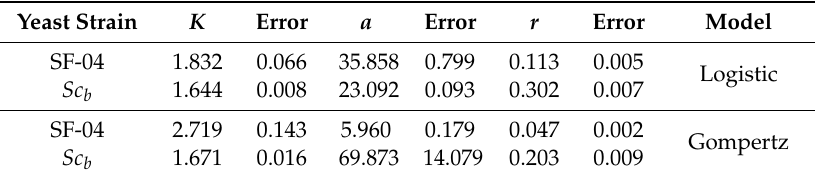
Table 3. Parameter estimates of k , a , r and their errors for the logistic and Gompertz models applied to the absorbance measurements at 630 nm for the Saccharomyces cerevisiae (SF-04) and Saccharomyces cerevisiae var. boulardii ( S Cb ) strains cultured in batch bioreactors at 24 ± 1 ◦ C for 50 h. All these results are statistically significant ( p < 0.05). Yeast Strain K Error a Error